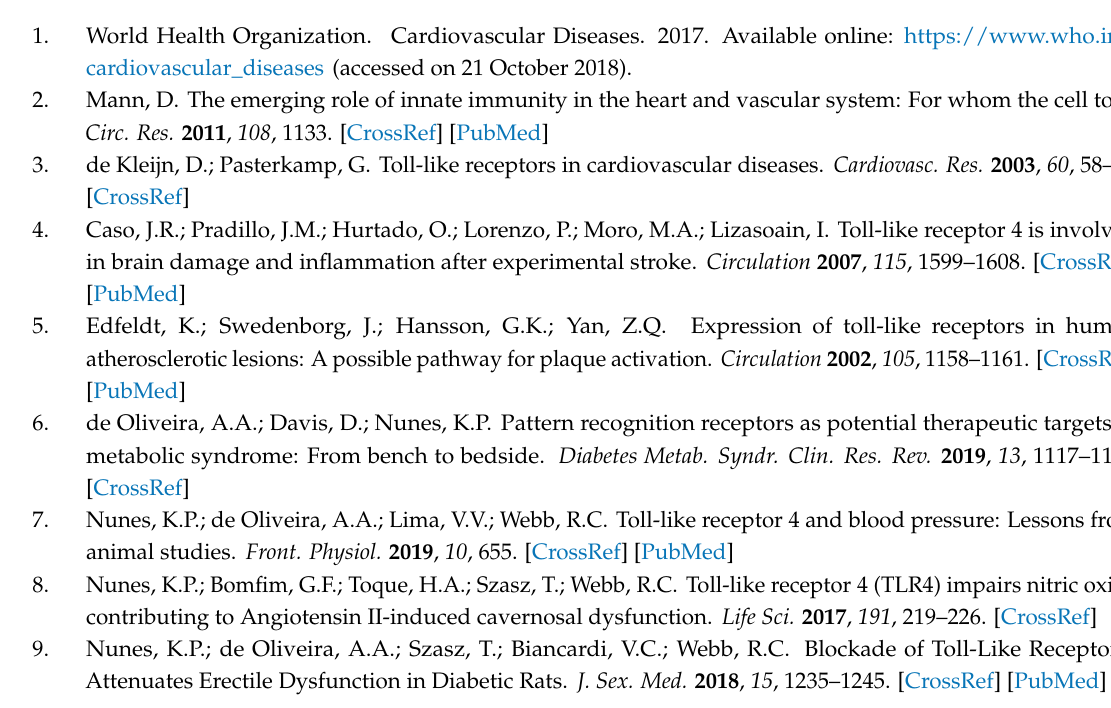
s1, Table S1: Descriptive values for the protein-protein interaction network of TLR4/MD2 and HSP70 family, Table S2: ρ correlation values for TLR4, MD2 and HSP70 family genes, Table S3: p -values for the Pearson ρ correlation of TLR4, MD2 and HSP70 family genes, Figure S1: Distribution of RNA expression of TLR4, MD2 and HSP70 family genes, Figure S2: Scatter plots of the relationship between expression values in heart (left ventricle) (A) and aorta (B) of TLR4 with MD2, as well as Pearson correlation ρ coefficient, and a Supplementary edgelist